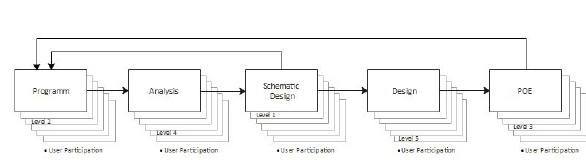
Figure 7. Functional participation model (source: